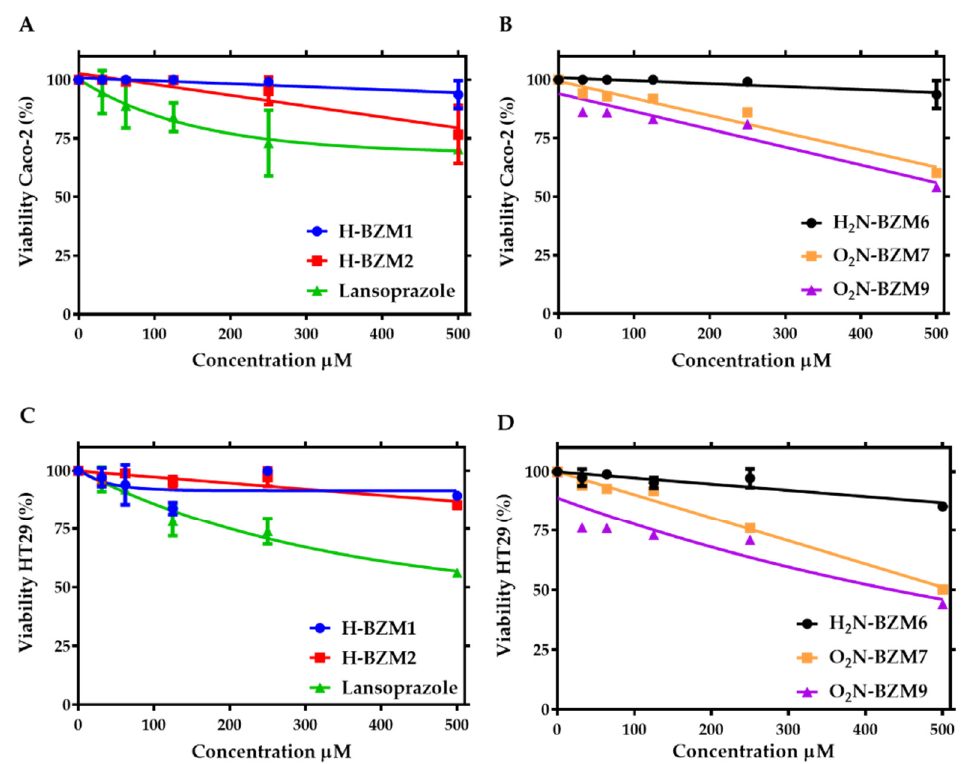
Figure 4. Cytotoxic e ff ect of compounds on Human Intestinal Caco-2 and HT29 cells Dose-response curves for cell viability of ( A ) Caco-2 cells and ( B ) HT29 cells treated with H-BZM1 , H-BZM2 , and H-BZM3 . Dose-response curves for cell viability ( C ) Caco-2 cells and ( D ) HT29 of HT29 cells treated with H 2 N-BZM6 , O 2 N-BZM7 , and O 2 N-BZM9 . The viability was determined by using an XTT assay. The values represent the mean ± standard deviation from three independent experiments, standard errors were lower than 5%.